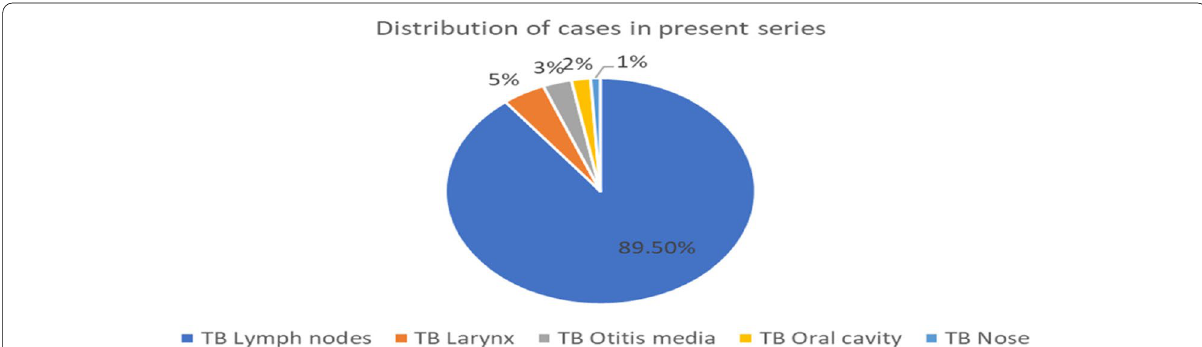
Fig. 1 Distribution of tuberculosis in ENT and neck